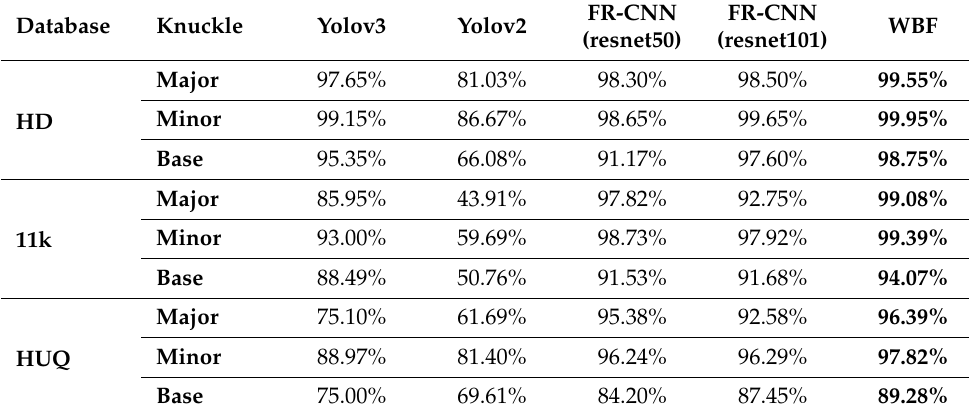
Table 1. Proportion of “suitable for identification” knuckles.